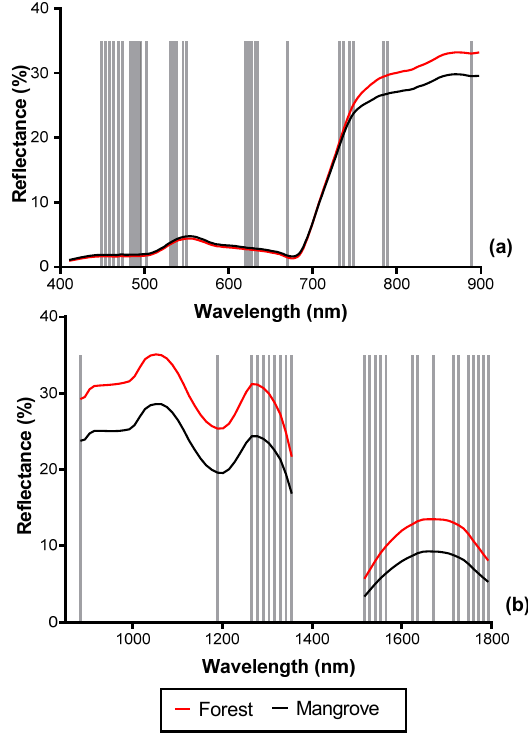
Figure 8. Spectral reflectance of mangrove and terrestrial forest with vertical lines showing the positions of the optimal bands selected by the forward feature selection (FFS). ( a ) 33 bands selected from the VNIR reflectance (2.5 m), ( b ) 26 bands selected from the SWIR reflectance (2.5 m) data.